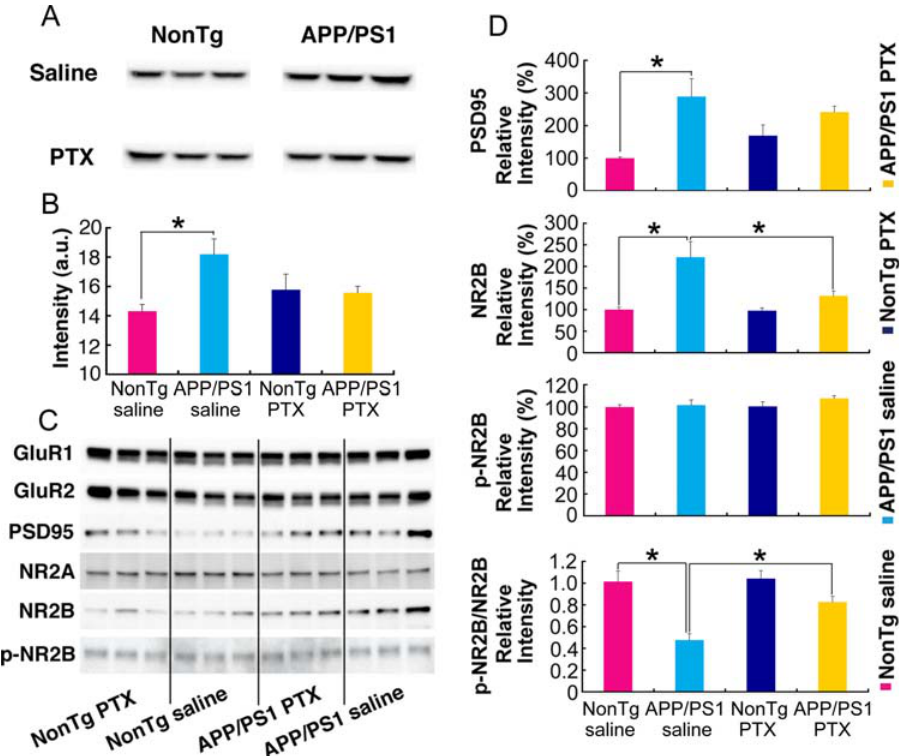
Figure 5. Modification of synaptic protein levels in adult APP/PS1 mice by PTX treatment. The effect of 10-day PTX treatment on the protein level of GABA A receptor a 1 subunit was examined by Western blot analysis of brain homogenates. (A, B) Immunoreactivity against the GABA A receptor a 1 subunit, as demonstrated by Western blotting, showed that the excess amount of this subunit in saline-treated APP/PS1 mice in comparison with the amount in saline-treated nonTg mice was absent in PTX-treated animals; *p=0.0274, two-tailed Student’s t-test. (C, D) Western blotting of membrane fractions from four groups of mice. Blots probed with antibodies against various receptors and PSD95 showed that the amounts of PSD95 and NR2B, but not other proteins, were higher in APP/PS1 mice than in nonTg mice. Because p-NR2B (NR2B phosphorylated at Tyr1472) did not differ among the four groups, the p-NR2B–to–total NR2B ratio in APP/PS1 mice was lower than that in nonTg mice. However, this difference between saline-treated nonTg and APP/PS1 mice was diminished by PTX treatment. Saline-treated nonTg mice vs. APP/PS1 mice: PSD95, *p=0.00873; NR2B, *p=0.00910; p-NR2B/NR2B, *p=0.00871; two-tailed Student’s t-test. Repeated measures two-way ANOVA also showed a significant difference in NR2B levels (F[1,4]=14.32, *p=0.0194) but not in PSD95 levels (F[1,4]=5.27, p=0.0834). Saline-treated APP/PS1 mice vs. PTX- treated APP/PS1 mice: NR2B, *p=0.0383; p-NR2B/NR2B, *p=0.0114; GABA A receptor a 1 subunit, not significant p=0.0810; PSD95, not significant p=0.4304; two-tailed Student’s t-test. Repeated measures two-way ANOVA also showed a significant difference in NR2B levels (F[1,4]=7.72, *p=0.0499) but not in PSD95 levels (F[1,4]=0.31, p=0.6070).